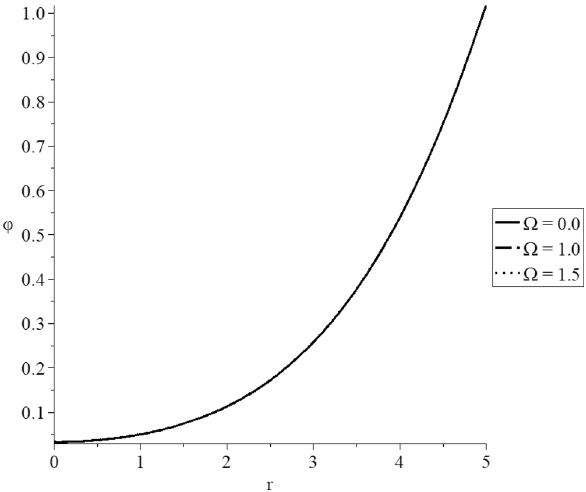
Figure 15. The conductive temperature increment distribution with various values of the angular velocity of the rotation parameter.